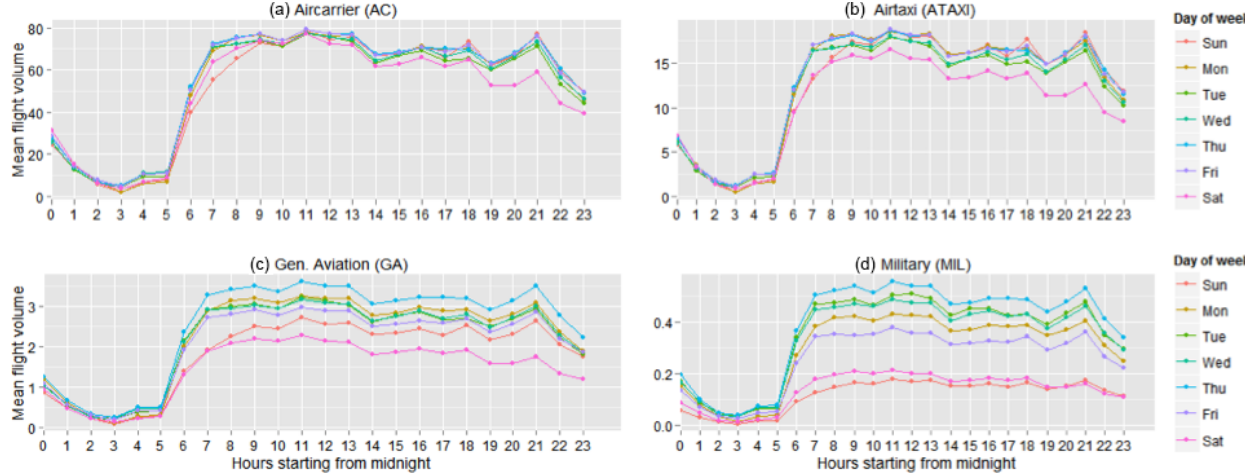
Figure 4. Average hourly flight volume at LAX for (a) total, (b) AC, (c) AT, (d) GA, and (e) MIL aircraft classes for each day of the week. The plots represent the mean diurnal cycle for all Mondays, Tuesday, Wednesdays, and so on, given a full year of data.